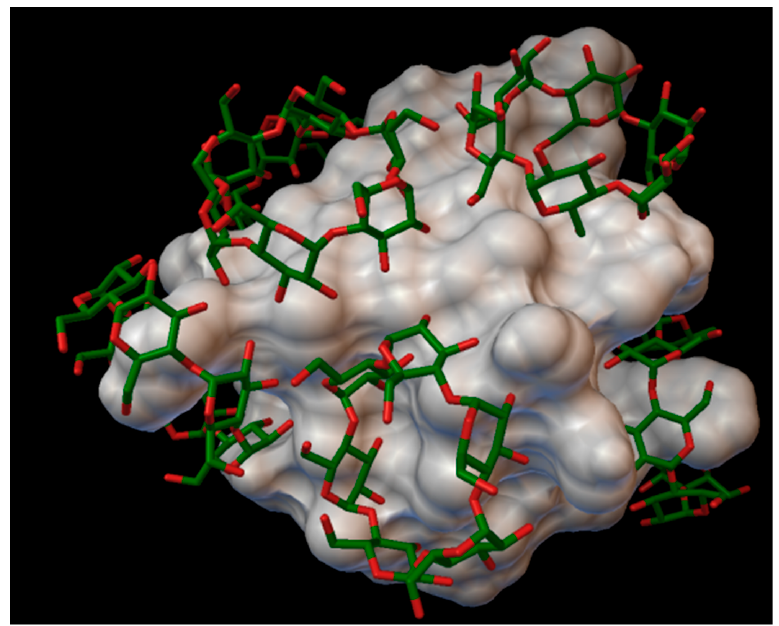
Figure 4. Insulin- α -cyclodextrin complex. The insulin molecular surface is marked in white and the cyclodextrin molecules are marked with with green and red licorice.